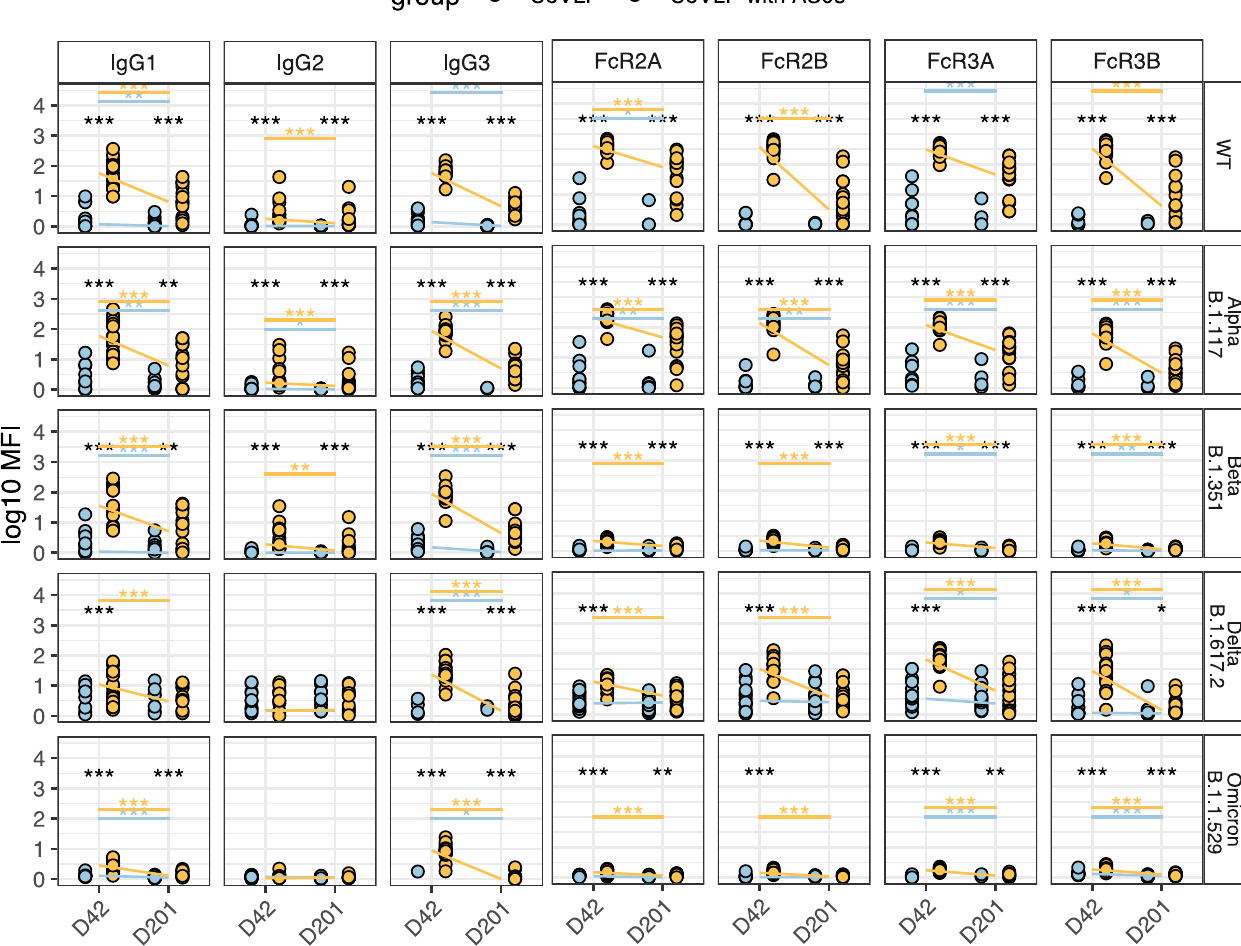
Fc γ R2A-, Fc γ R2B-, Fc γ R3A- and Fc γ R3B-binding levels across the vaccinees that received the CoVLP with AS03 (yellow, n = 17) and CoVLP without AS03 (blue, n = 16) at days 42 and 201. Lines connect the median values of groups. All data were divided by negative control. Differences were de fi ned using a Wilcoxon rank-sum test, and all p values were corrected for multiple comparisons using the Benjamini- Hochberg (BH) method, with *** p < 0.001, ** p < 0.01, * p <